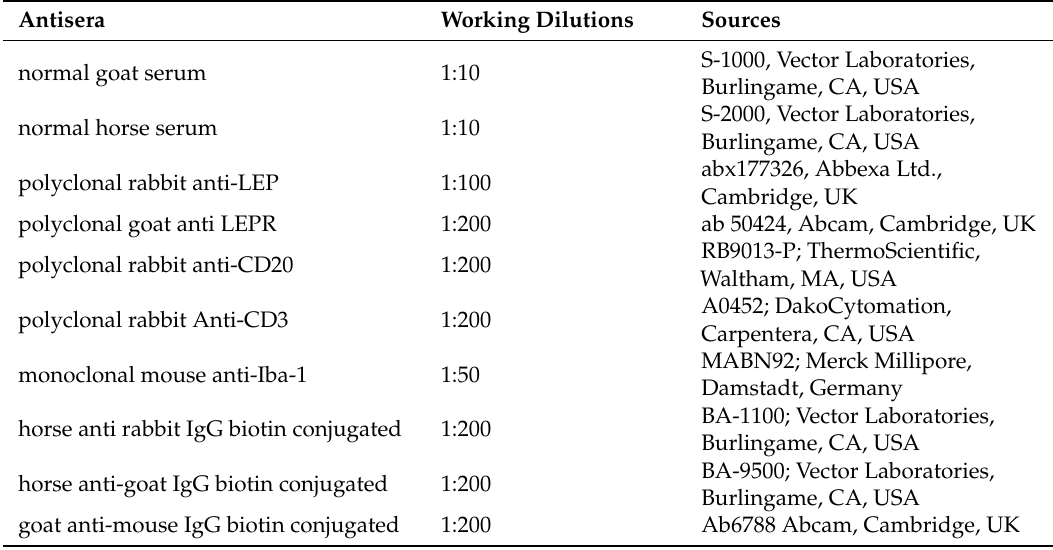
Table 1. Source and working dilutions of the antisera